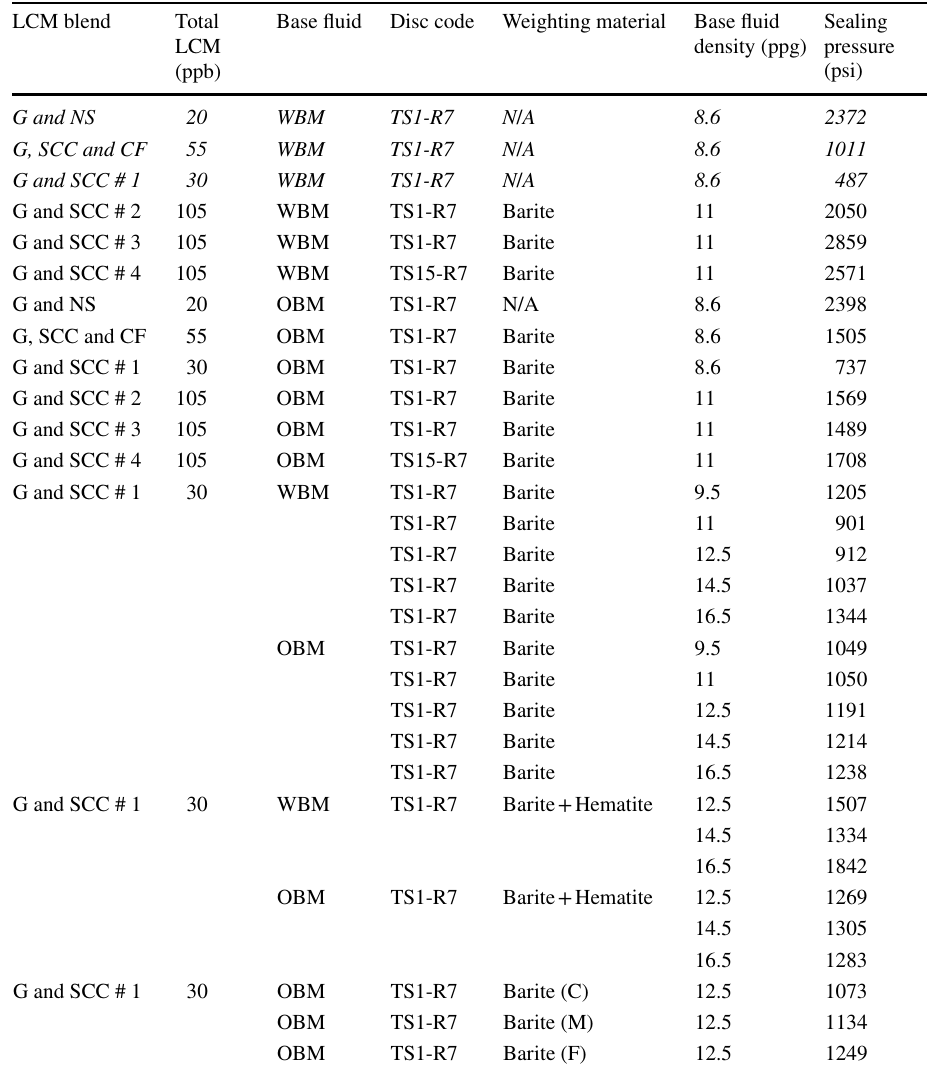
Table 4 Summary of the results from previous studies (Alsaba et al. 2014a, b) and this